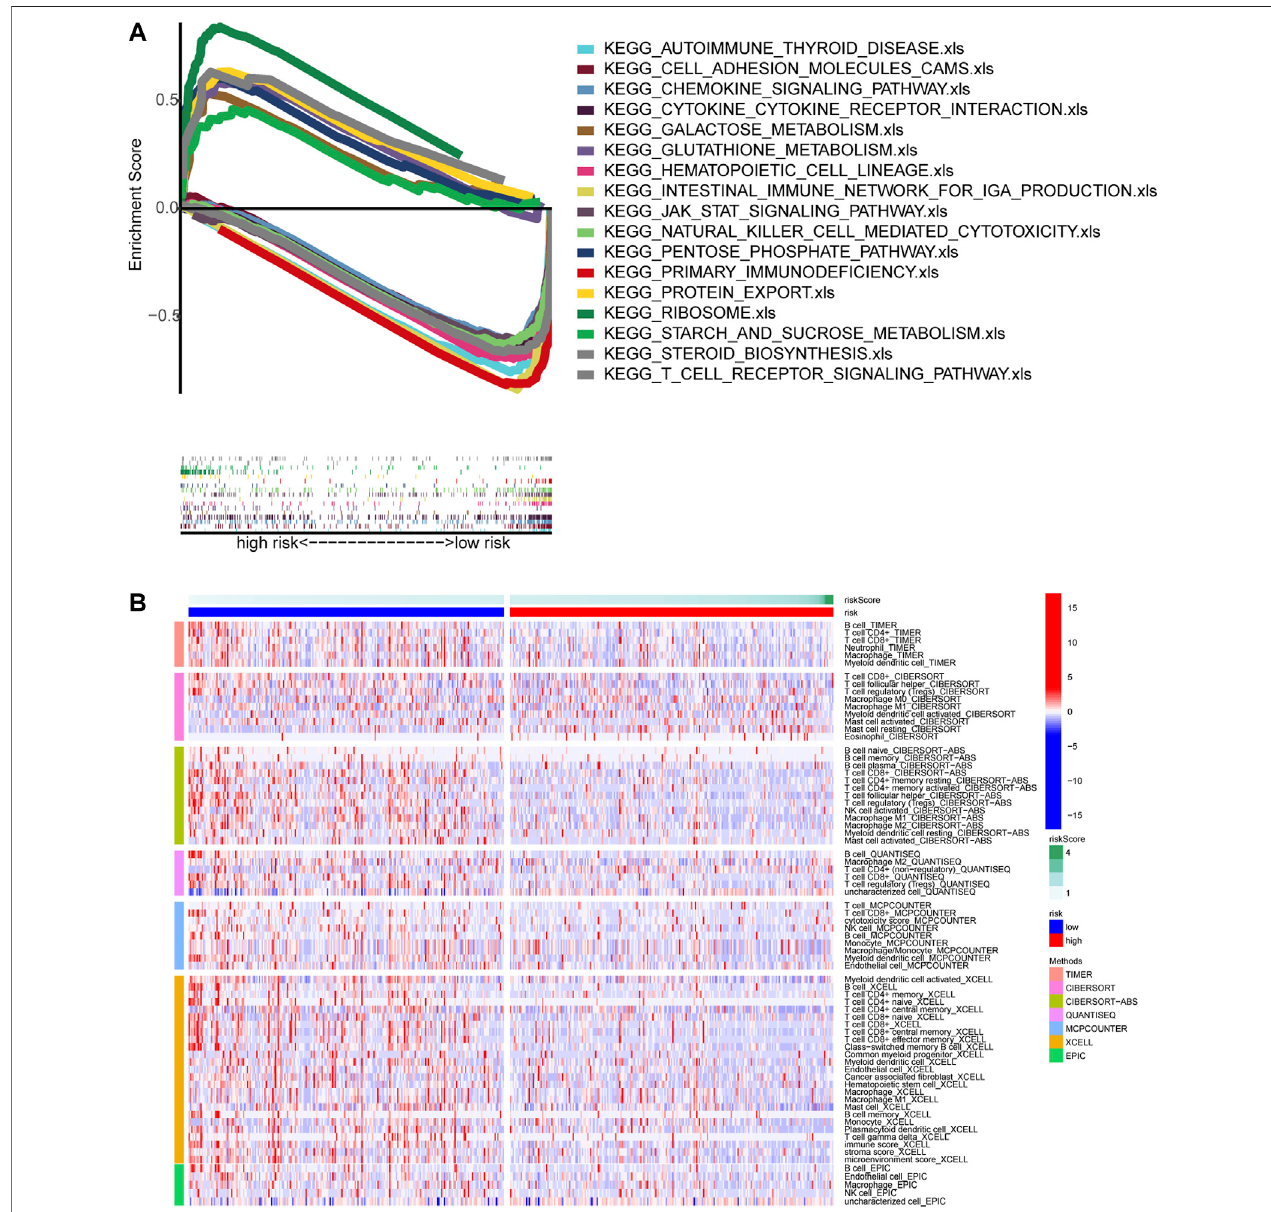
FIGURE 6 | TME and immunotherapy. (A) Top 10 pathways identi fi ed by GSEA (B) The heat maps of immune cells. (C) Risk scores were corrected with immune cells. (D) ssGSEA scores of immune functions. (E) Comparison of immune-related scores between the two groups. (F) The expression of 34 checkpoints. (G) Twelve targeted and immunotherapeutic drugs with different IC50 between the low-risk group (green) and the high-risk group (red).